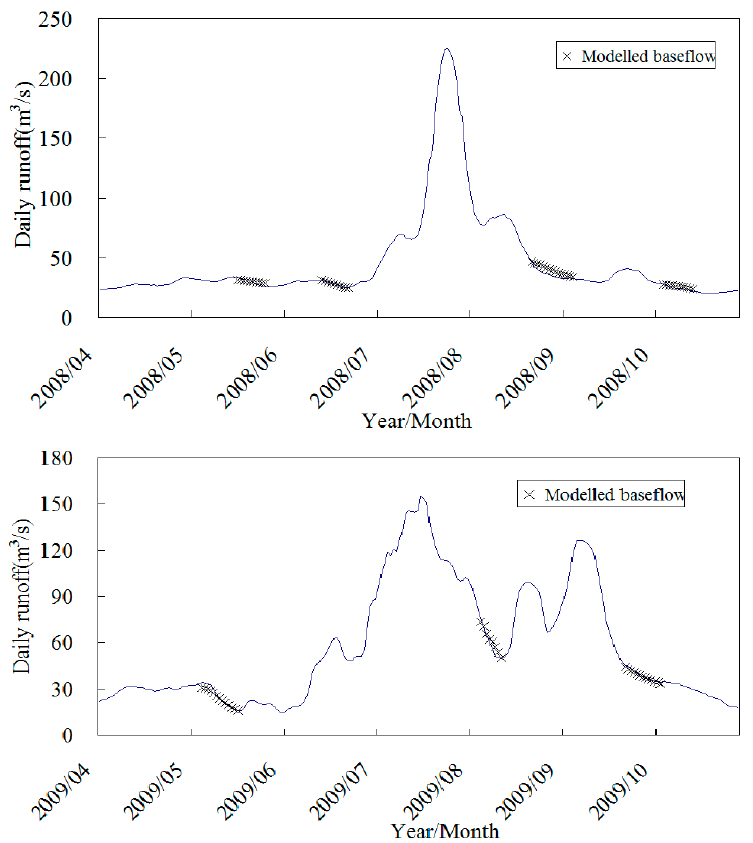
Figure 6. The predicted and observed baseflow in the upper reaches of the Shule River, during the recession periods of 2008–2009. recession periods of